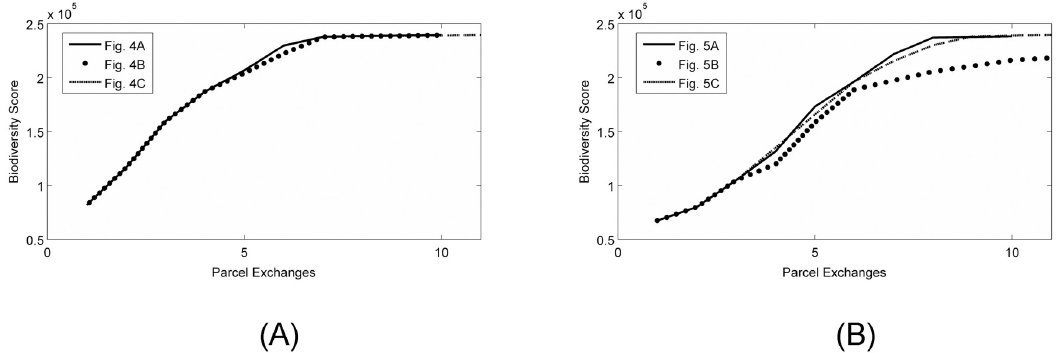
Fig 8. Ranking system for the viable options that arise from different initial landscapes. (A) Mosaic richness indices along the paths shown in Fig 6 that originated from the initial landscape shown in Fig 4A. The mosaic richness indices of the intermediate landscapes that occur along the three different paths are very similar, so much so that it is difficult to differentiate between the dashed line (corresponding to Fig 6C) and the solid line (corresponding to Fig 6A). Thus, for this initial condition, it is clear that several good options exist that do not correspond to dominant minimal paths (e.g., the dashed and dotted lines), and highlights the reason one may want to consider minimal deviants. (B) Mosaic richness indices along the paths shown in Fig 6 that originated from the initial landscape shown in Fig 5A. For this initial condition, the mosaic richness indices of the intermediate landscapes vary considerably along the paths. It is clear that the path shown in Fig 7B (dotted line) is not the best choice for this initial landscape. Alternatively, the paths shown in Fig 7A and 7C are comparable, but the graph supports the argument that, in this situation, maybe the path shown in Fig 7C (dashed) that leads to a global optimum is not as good as the locally optimal path shown in Fig 7A